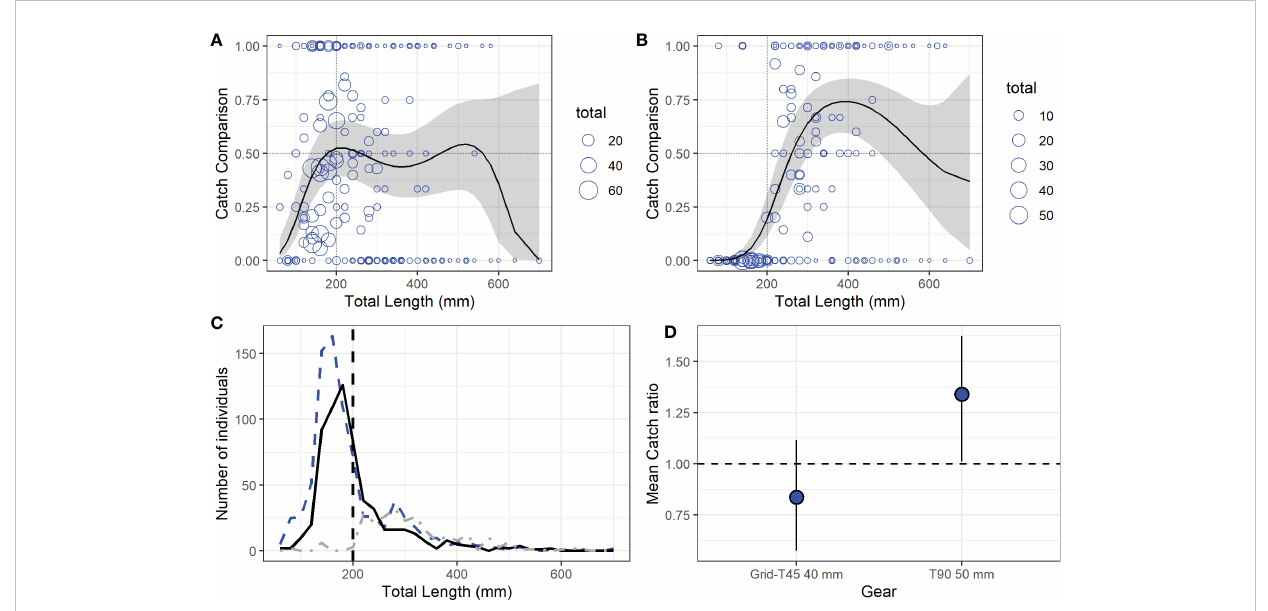
FIGURE 6 (A) Catch comparison curves for HKE caught with the Grid-T45 40 mm, and (B) with the T90 50 mm codend. Blue circles show observed proportions by haul, black dashed lines represent the model prediction, and the grey band indicates the 95% con fi dence limit. The level of no effect (CC( l ) = 0.5) is shown by horizontal black dashed lines while the MCRS is shown by the black vertical dashed lines. (C) Length frequency distributions of DPS caught during the campaign. The blue dashed line represents the control, the continuous black line represents the Grid-T45 40 mm, and the dark grey line represents the T90 50 mm codend. Black vertical dashed lines depict the MCRS according to the Reg. EU 1241/2019. (D) The blue dots indicate the mean catch ratio (CR( l )), and horizontal bars indicate the 95% con fi dence limit. The level of no effect (CR( l) = 1.0) is depicted by horizontal black dashed